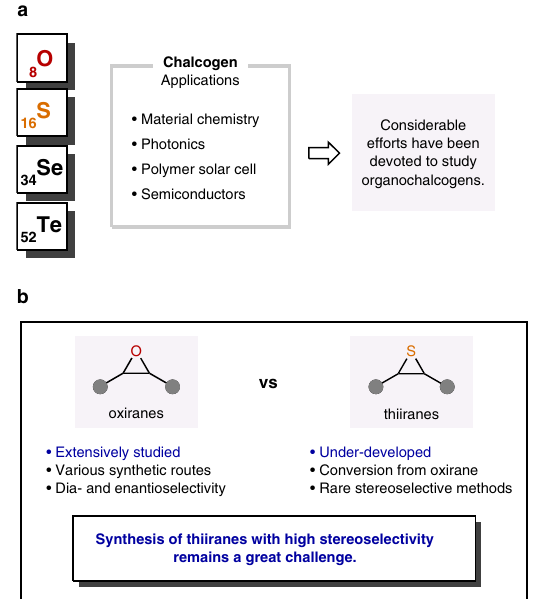
Fig. 1 | Thiiranes as synthetic targets. a Importance of organochalcogens. b Comparison between oxiranes and thiiranes.